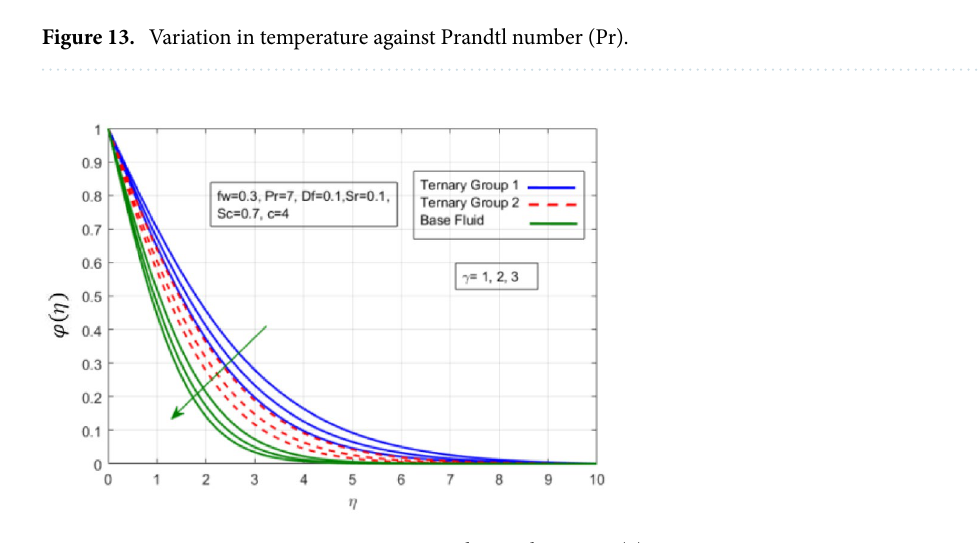
Figure 14. Variation in concentration against chemical reaction